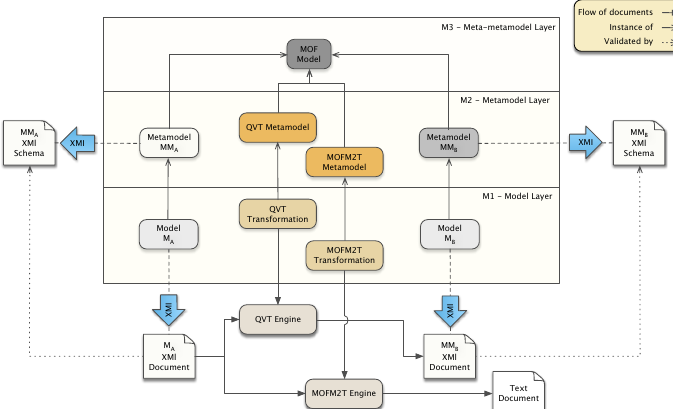
Figure 2. Overview of MDA